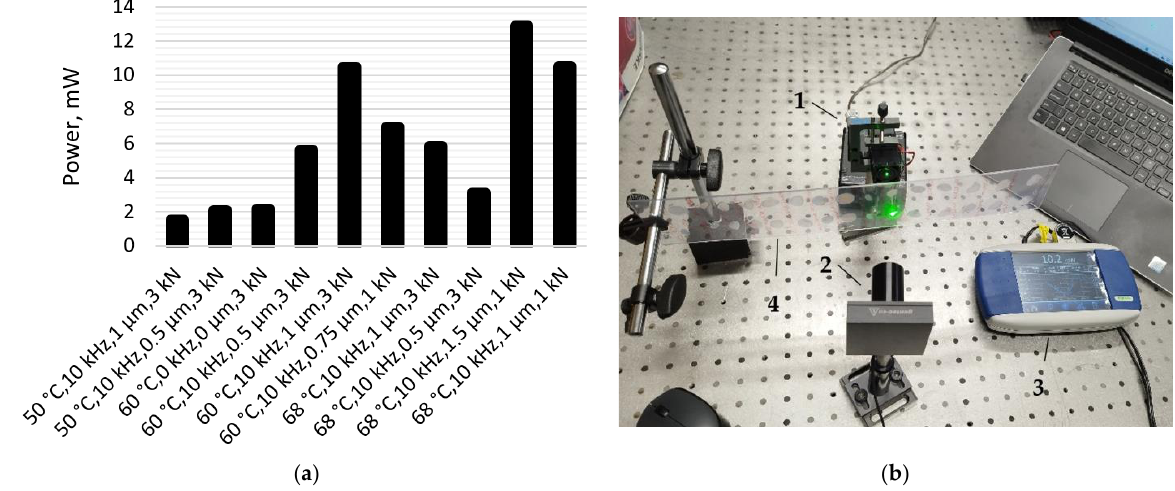
Figure 8. ( a ) Diffraction efficiency measurement results; ( b ) measurement equipment: 1 — laser (OX- MZ5201, OXLasers, China), 2 — laser detector (11UP12, Gentec, Canada), 3 — energy monitor (201235, Gentec, Canada), 4 — grid. MZ5201, OXLasers, China), 2—laser detector (11UP12, Gentec, Canada), 3—energy monitor (201235, Gentec, Canada),